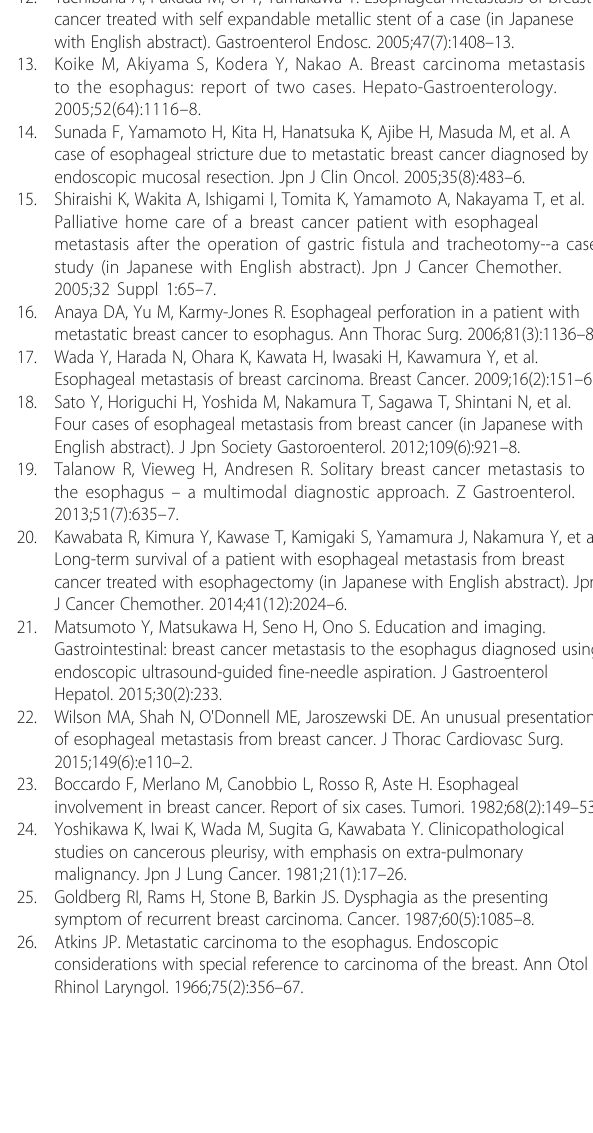
Abbreviations 5-DFUR: Doxifluridine; CMF: Cyclophosphamide, methotrexate, and